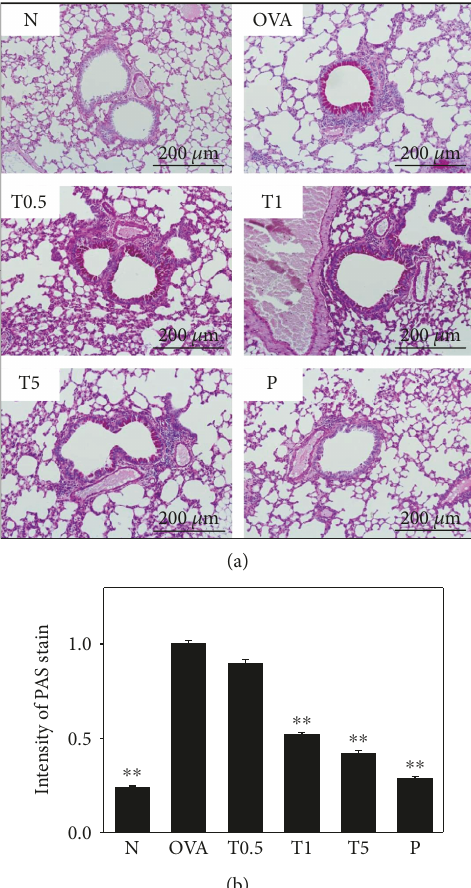
Figure 3: (a) PAS-stained lung sections show goblet cell hyperplasia in lung tissue (200x magni fi cation). (b) Results expressed as the intensity of PAS stain. All data are presented as means ± SEM. ∗∗ P < 0 01 compared to the OVA control